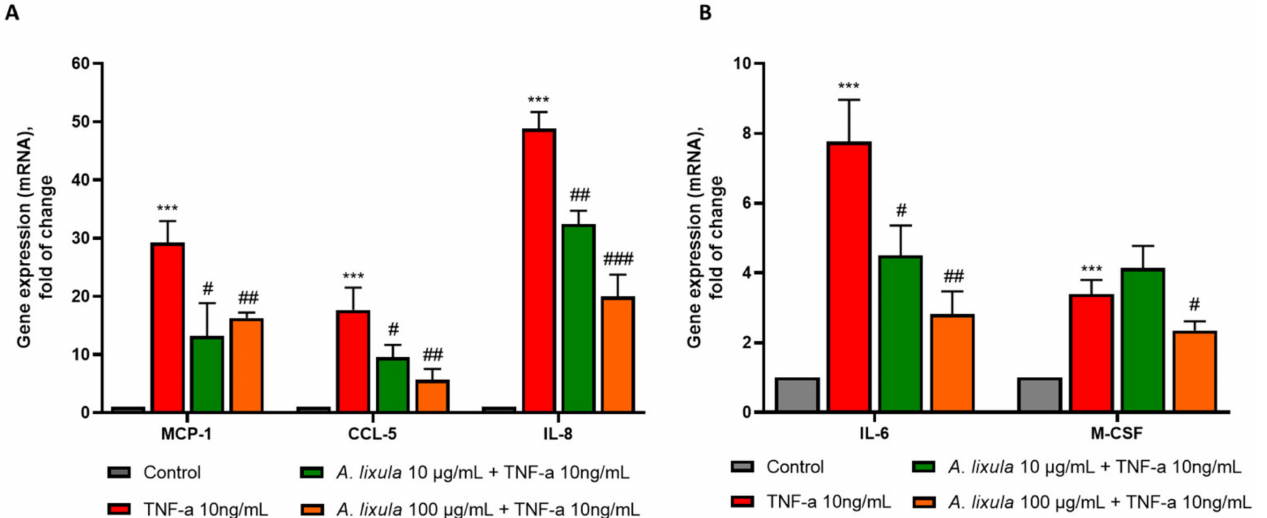
Figure 4. Effect of A. lixula extract on TNF- α -induced expression of inflammatory genes in human endothelial cells. HMEC-1 were treated with A. lixula extract for 4 h at the concentration indicated, and then either treated with 10 ng/mL TNF- α or left untreated for 18 h. mRNA levels of MCP-1, CCL-5, IL-8 ( A ), IL-6, and M-CSF ( B ) were measured by qPCR. Data (means ± S.D., n = 3) are expressed as fold induction over basal (untreated) control. *** p < 0.001 vs. basal (untreated) control; # p < 0.05 vs. TNF- α alone; ## p < 0.01 vs. TNF- α alone; ### p < 0.001 vs. TNF- α